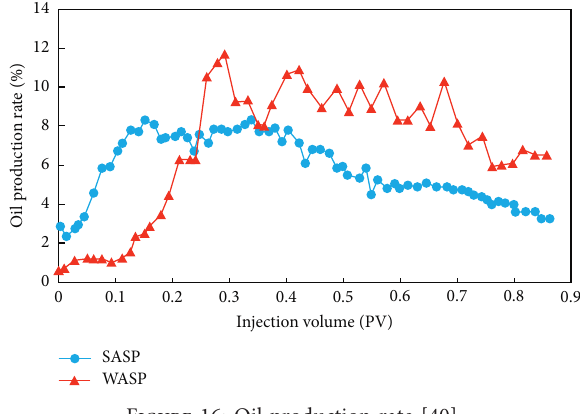
Figure 16: Oil production rate [40].